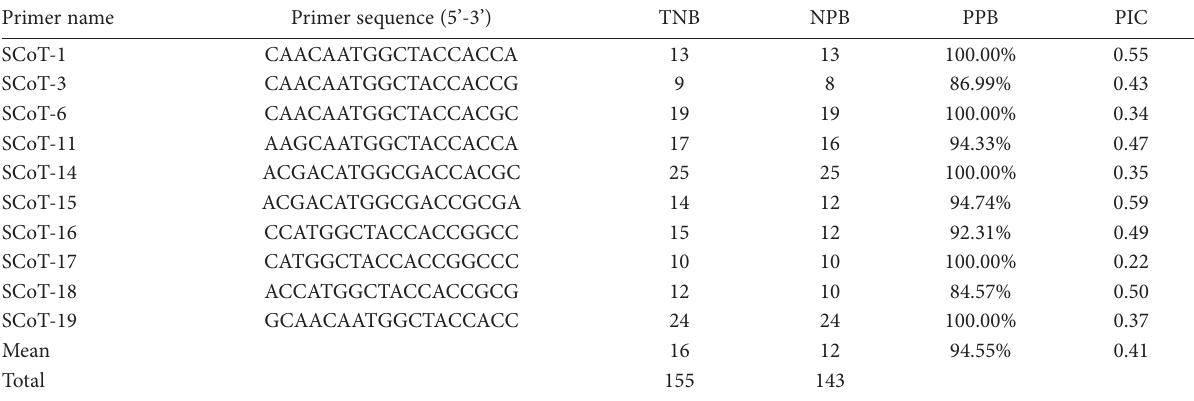
Table 2. SCoT primers used for this study and the extent of polymorphism. TNP: total number of bands; NPB: number of polymorphic bands; PPB: percentage of polymorphic bands; PIC: polymorphism information content.